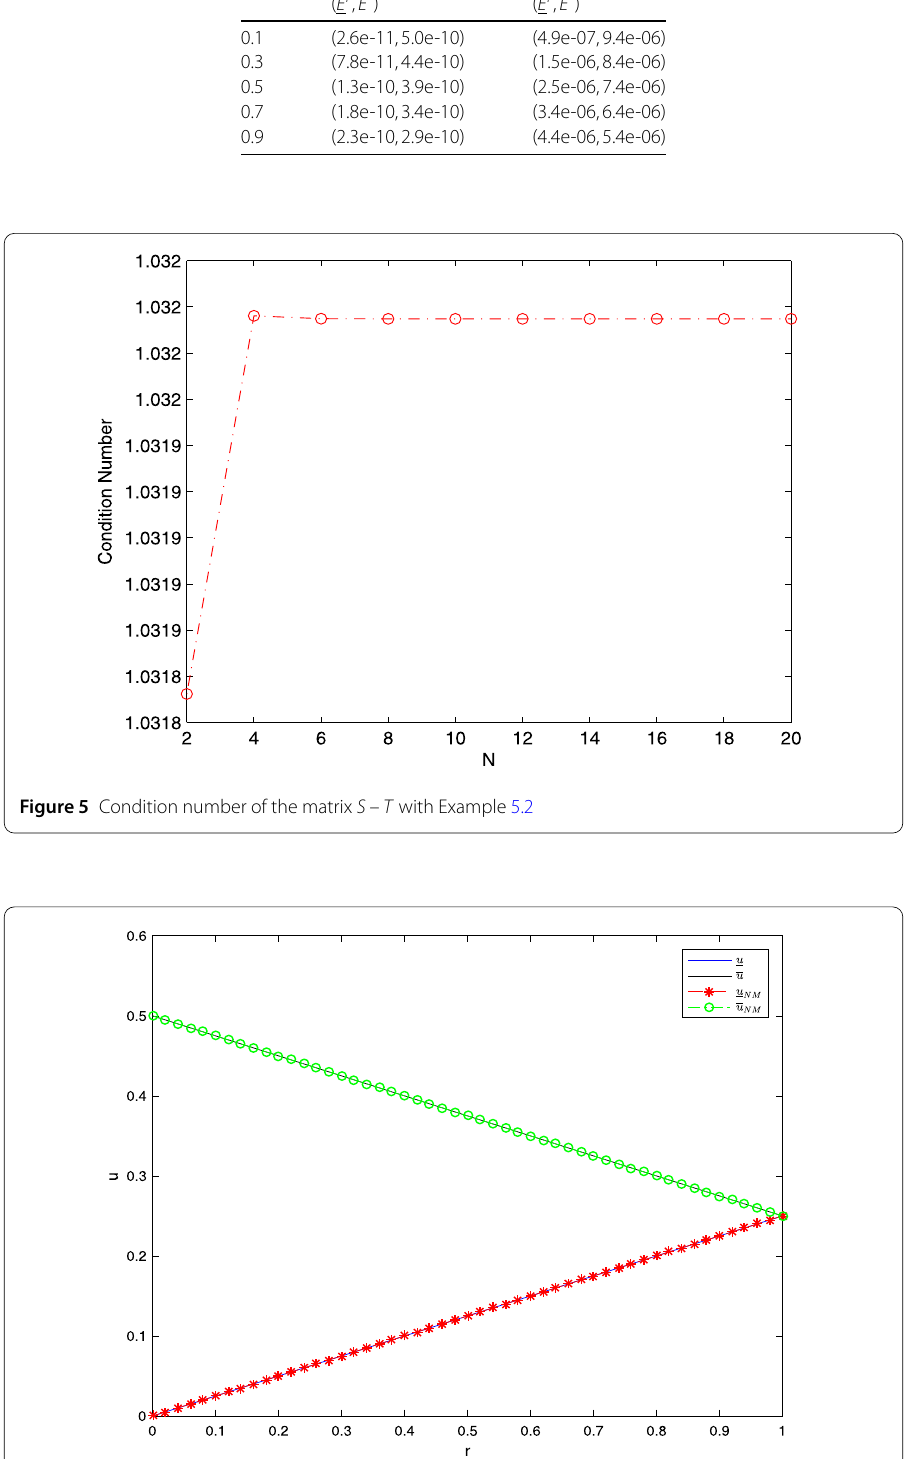
Figure 6 Exact solution and approximate solution with N = 2 of Example